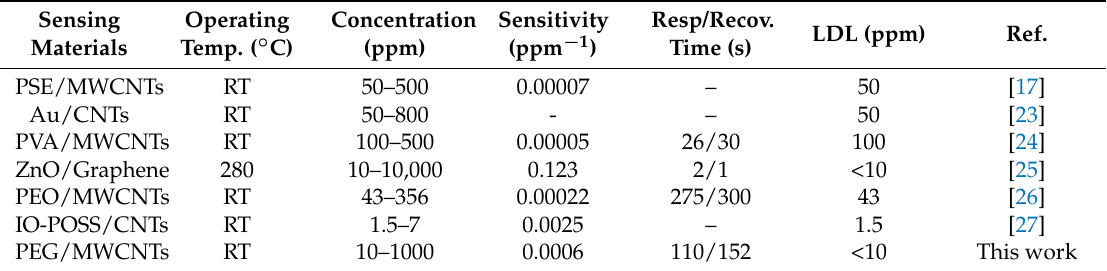
Figure 11. Radar plots of the response for four kinds of VOCs. Table 2. Comparison of this work with various carbon nanotube-based gas sensors reported in the literature.